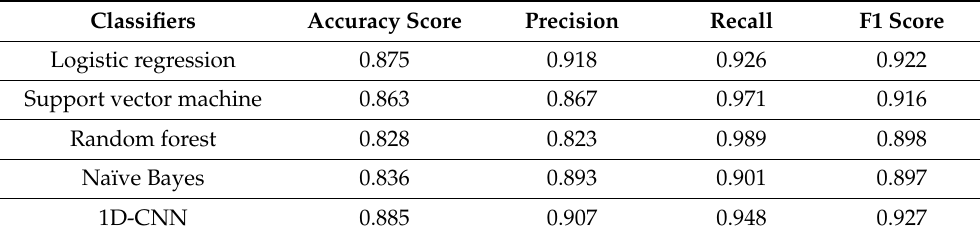
Table 6. Overall result analysis of proposed classifier.